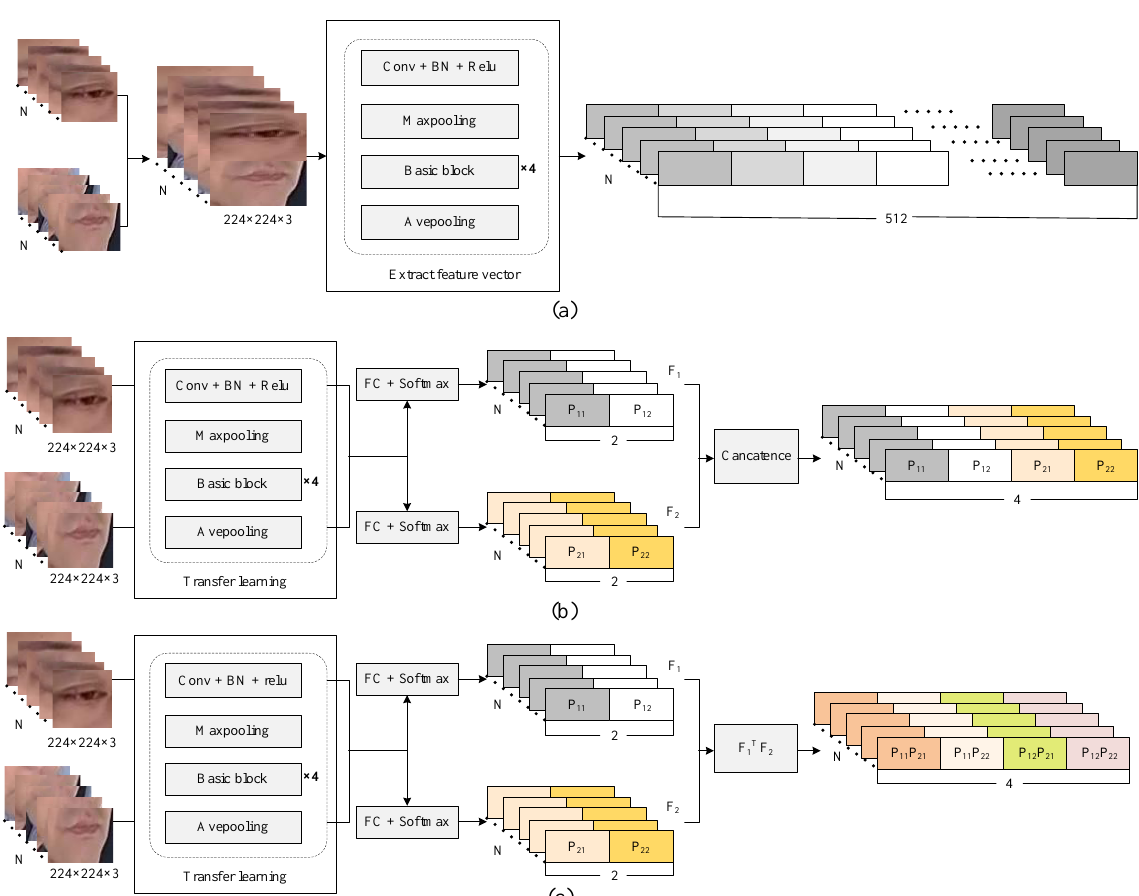
Figure 6. Feature coding strategies. ( a ) Feature-level frame aggregation. ( b ) Decision-level frame aggregation based on vector stitching. ( c ) Decision-level frame aggregation based on the vector dot product.